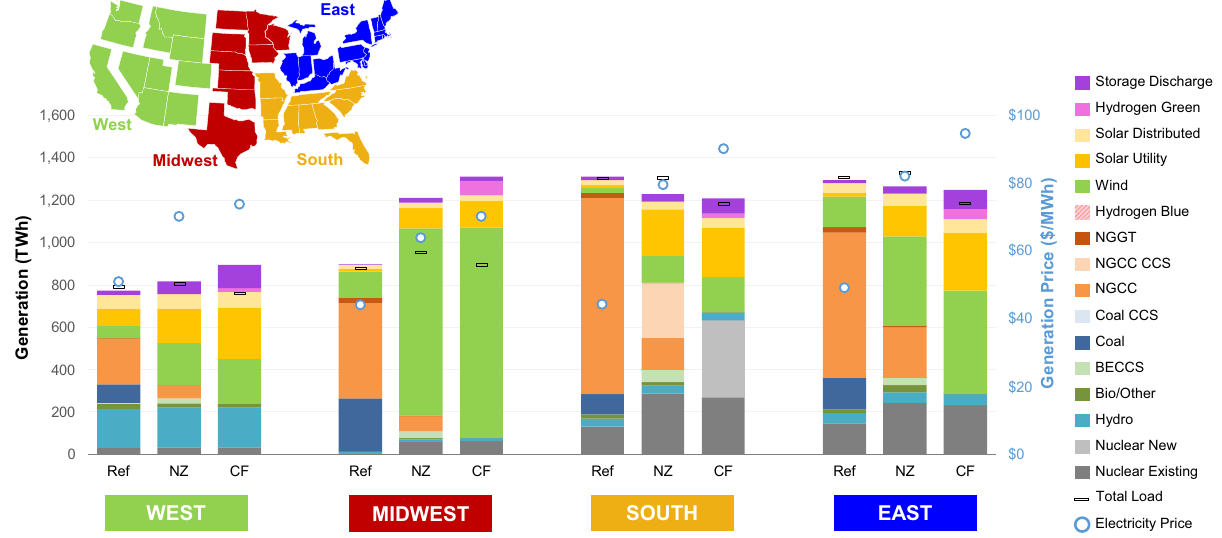
Fig. 3 | Regional implications of policy targets on generation and electricity prices. Results are shown for the three policy scenarios (Ref Reference; NZ Net- Zero;CFCarbon-Free).Thegeneration-weightedaverageprice($/MWh)re fl ectsall generation,newbulktransmission,carbonremoval,andCO 2 transportandstorage